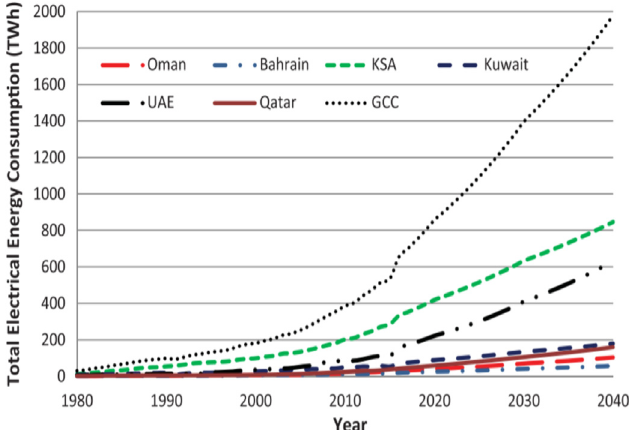
Fig. 4. Electrical energy consumption in the GCC, 1980 – 2040 [20].